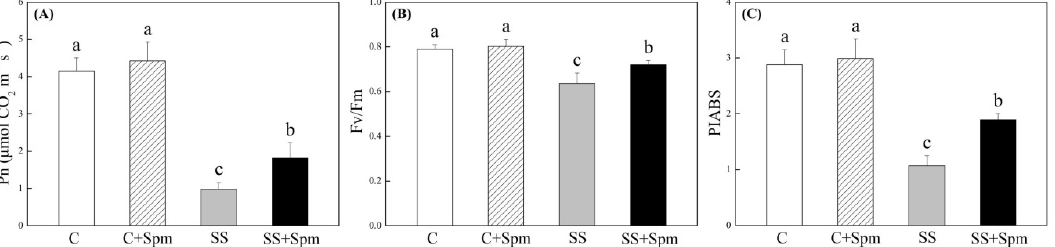
Figure 2. Effects of exogenous application of spermine (Spm) on ( A ) net photosynthetic rate (Pn), ( B ) photochemical efficiency of PS II (Fv/Fm), and ( C ) performance index on absorption basis (PI-ABS) under normal conditions and salt stress. Vertical bars indicate ±SE of mean (n = 4). Different letters above columns indicate significant differences based on LSD ( p < 0.05). C, control; C + Spm, control + Spm; SS, salt stress; SS + Spm, salt stress + Spm.